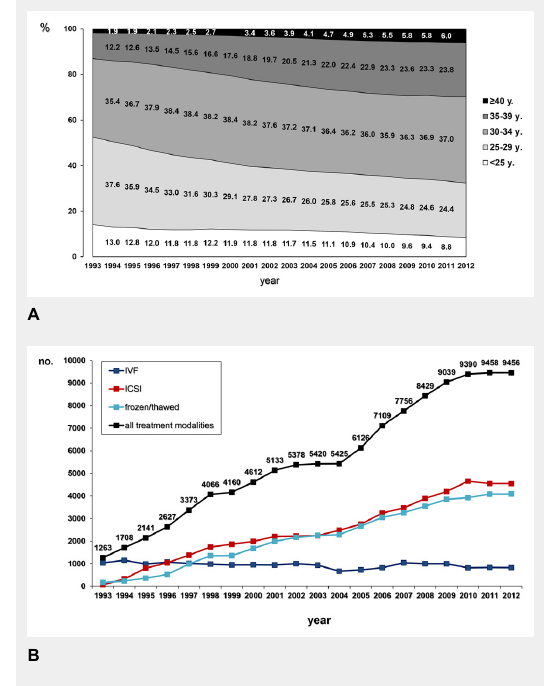
A Age of women giving birth in Switzerland between 1993 and 2012 was extracted from the data base constructed and published by the Swiss Federal Office of Statistics (BfS). During this observation period the proportion of women giving birth at the age of 35 to 39 years or older has nearly doubled, whereas the age of women giving birth at the age of 40 years or older has risen more than threefold. B During the observation period between 1993 and 2012 the number of treatments with ART, including IVF, ICSI and the transfer of frozen/thawed embryos and oocytes at the pronucleate stage, has risen almost continuously, as evidenced by the Swiss ART data registry,